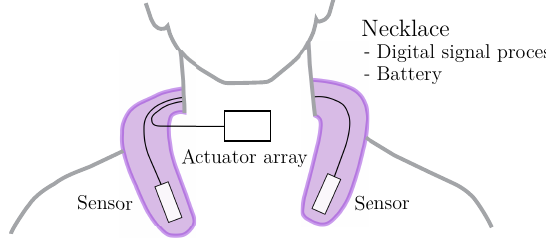
Figure 11. Concept of a wearable necklace